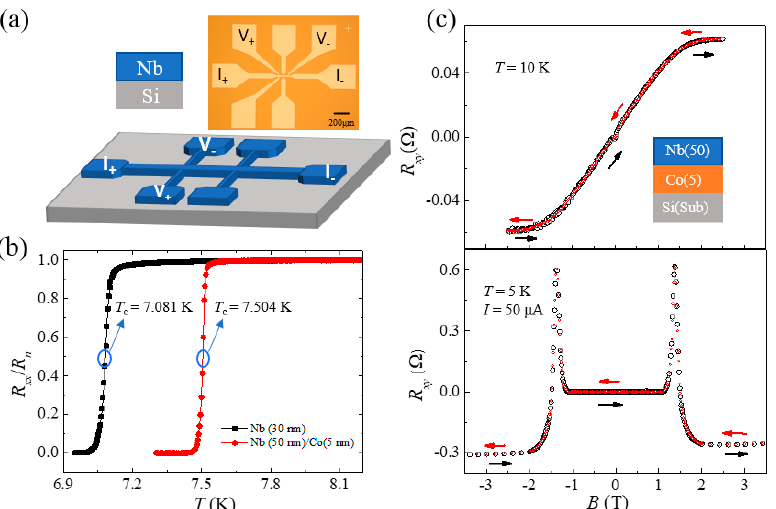
Figure 1. ( a ) Sketch structures and the optical microscopy of a typical Hall bar device, with a standard four-terminal configuration for measuring the transverse resistance. ( b ) The R N - T curve of samples Nb (30 nm) black dots and Nb (50 nm)/Co (5 nm) red dots, and R N = R xx / R n . ( c ) The R xy as a function of the applied magnetic field B of the Nb (50 nm)/Co (5 nm) at T = 10 K (top panel) and 5 K (bottom panel), respectively. Red and black arrows indicate the sweeping magnetic field